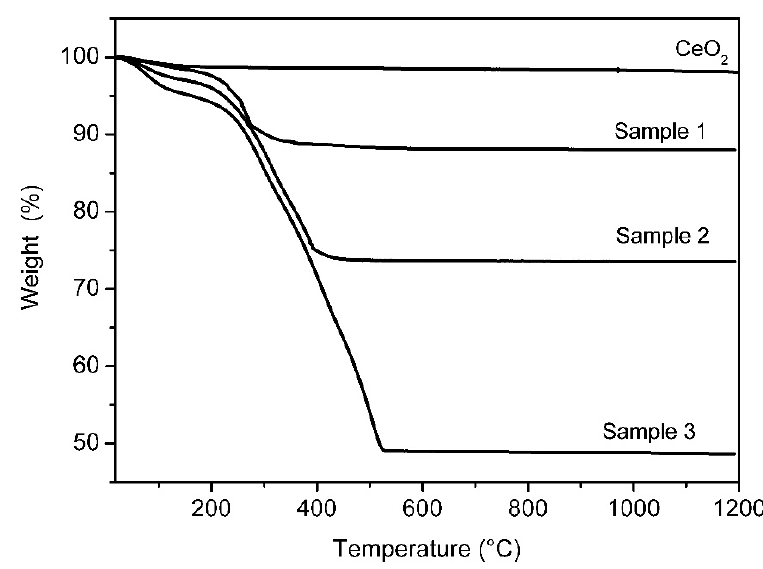
Figure 4. Weight loss curves for bare CeO 2 and for PDAx@CeO 2 samples.